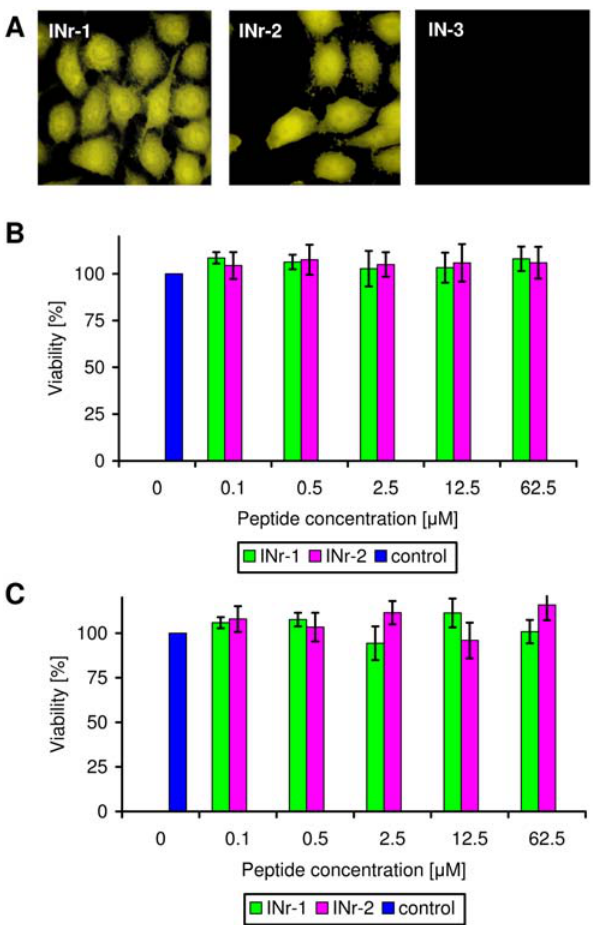
Figure 4. Cell penetration and toxicity of INr peptides. (A) Fluorescein-labeled INr-1, INr-2, and IN-3 (a known nonpermeable peptide [37]) each at 10 m M, were incubated for 2 h at 37 u C with HeLa cells. The cells were then washed three times with PBS and visualized by confocal microscopy. (B) Cell toxicity was determined by MTT assay in HeLa TZM-bl cells. (C) Same as (B) but in H9 lymphocytes. Experimental conditions are described in Materials and Methods.